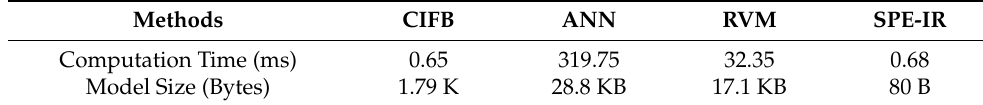
Table 11. Comparison of multi-faults computation time and model size.